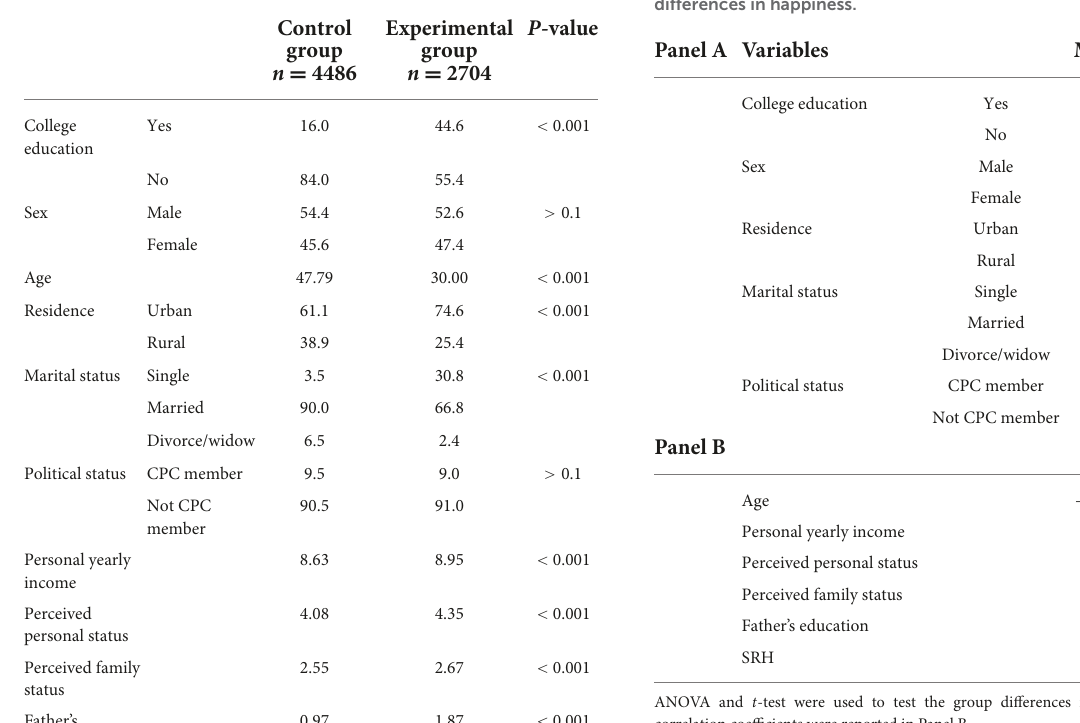
TABLE 2 Differences between experimental and control groups. TABLE 3 Univariate analysis on the population